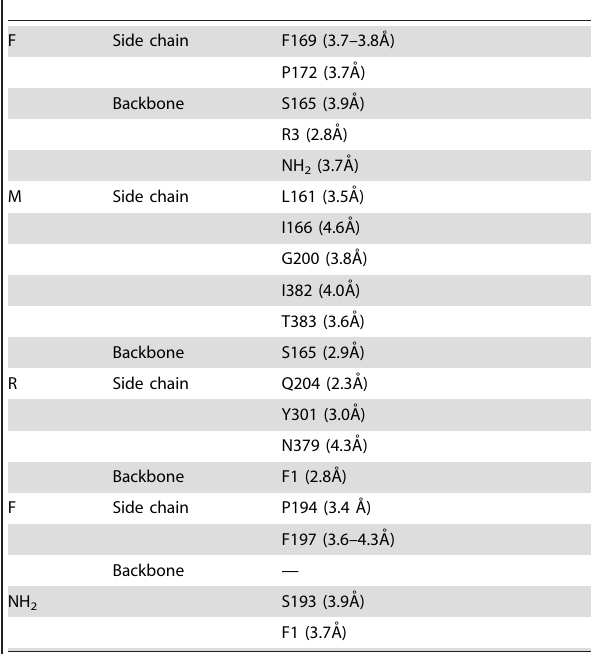
Table 2 . FMRF-NH 2 ligand-receptor contact sites, pose A a .